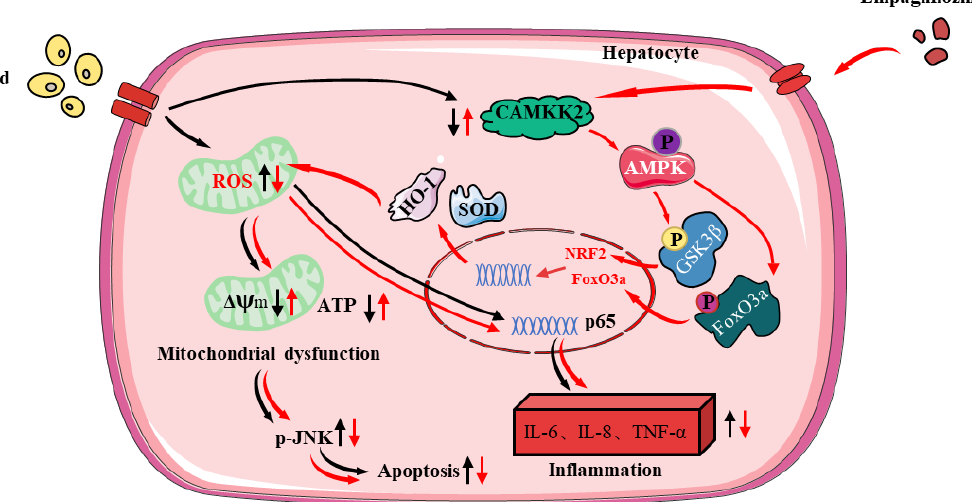
Figure 8. The protective mechanisms of Empa on PA-induced lipotoxicity in LO2 cell lines.